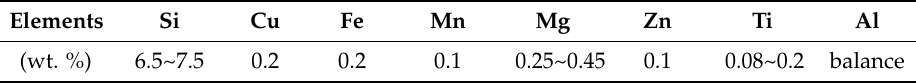
Table 1. Chemical composition of A356 alloy (wt. %).